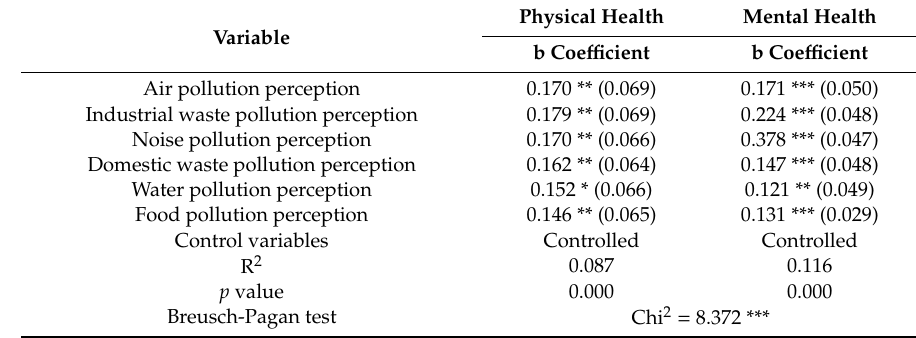
Table 5. Influences of ERP on migrant construction workers’ physical and mental health by SUR ( N = 678). Variable